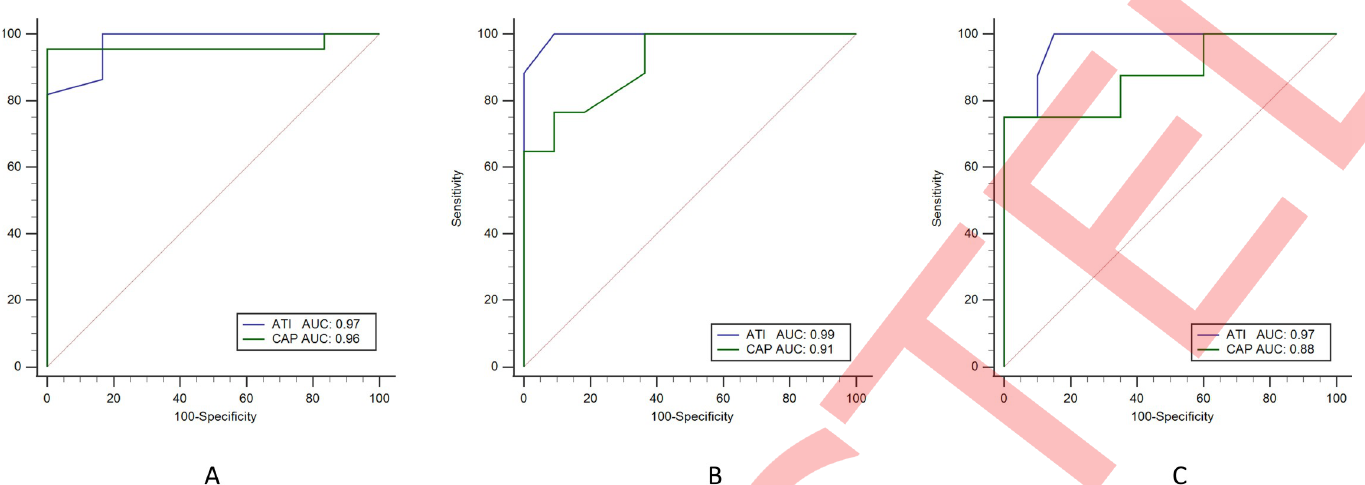
Fig 5. Comparing AUROC for ATI and CAP for detecting different grades of liver steatosis. A: Liver steatosis grade S1 or higher with AUROC values of 0.97 (95% CI: 0.83–1.00) for ATI (blue line) and 0.96 (95% CI: 0.81–0.99) for CAP (green line). B: Liver steatosis grade S2 or higher with AUROC values of 0.99 (95% CI: 0.86–1.00) for ATI and 0.91 (95% CI: 0.74–0.98) for CAP. C: Liver steatosis grade S3 with AUROC values of 0.97 (95% CI: 0.82–1.00) for ATI and 0.88 (95% CI: 0.70–0.97) for CAP. AUROC: area under the receiver operating characteristic curve; ATI: attenuation imaging; CAP: controlled attenuation parameter.